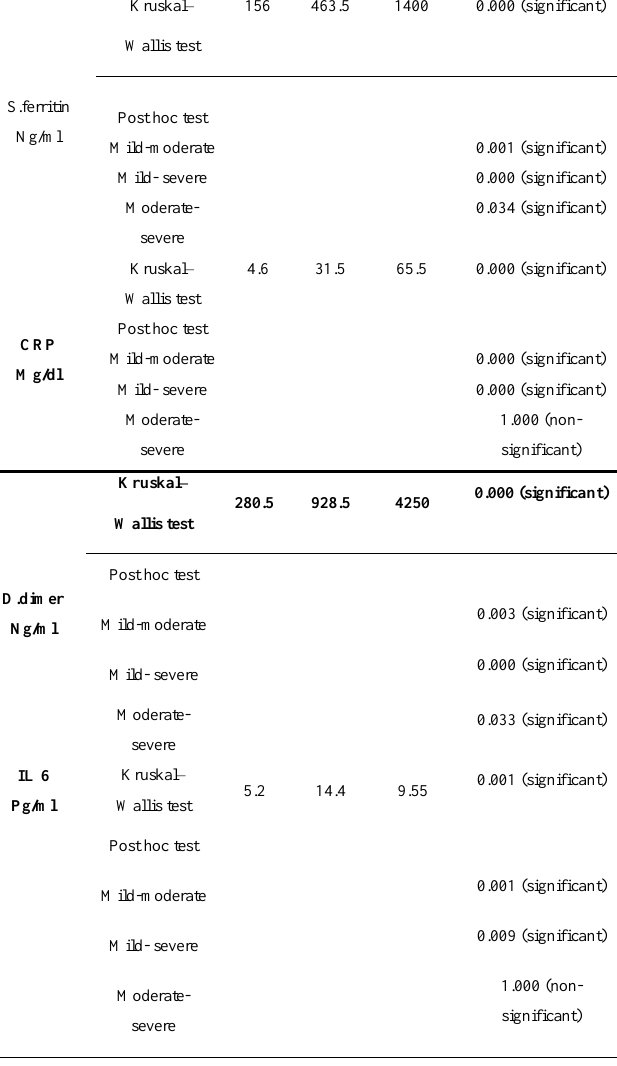
Table 4 : Spearman’s correlation test for IL 6 with hematological and inflammatory parameters in the 60 cases included in the